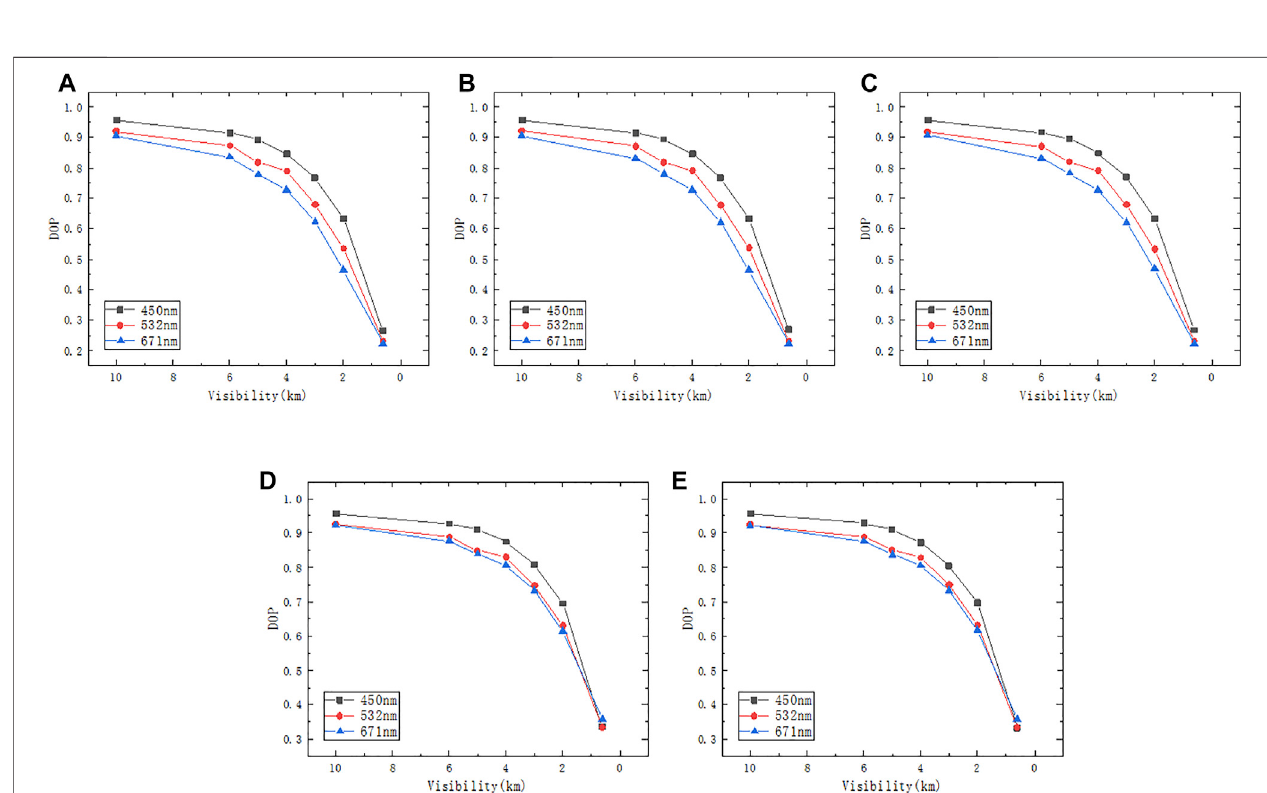
FIGURE4| Simulationcurves ofpolarizationtransmissioncharacteristics ofdifferentpolarizationstates: (A) 0 ° , (B) 45 ° , (C) 90 ° , (D) left-hand rotation,and (E) right- hand rotation.